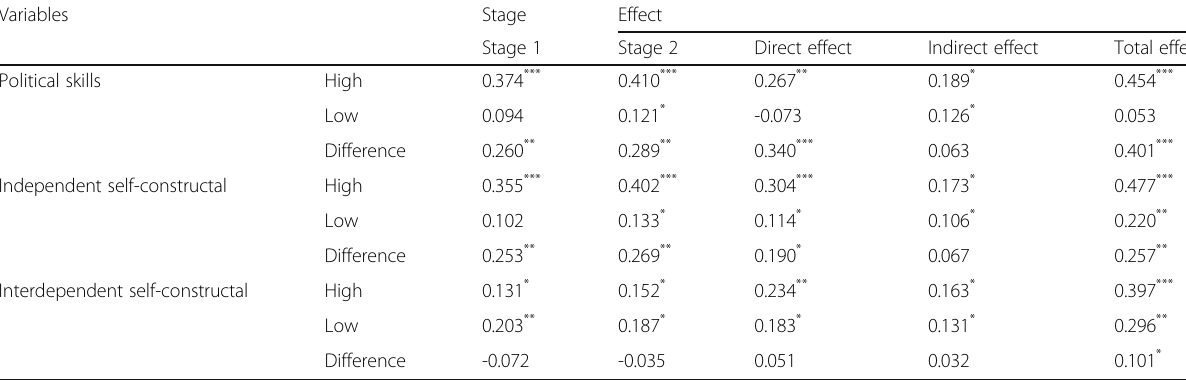
Table 3 Moderation effect of political skills and self-constructal